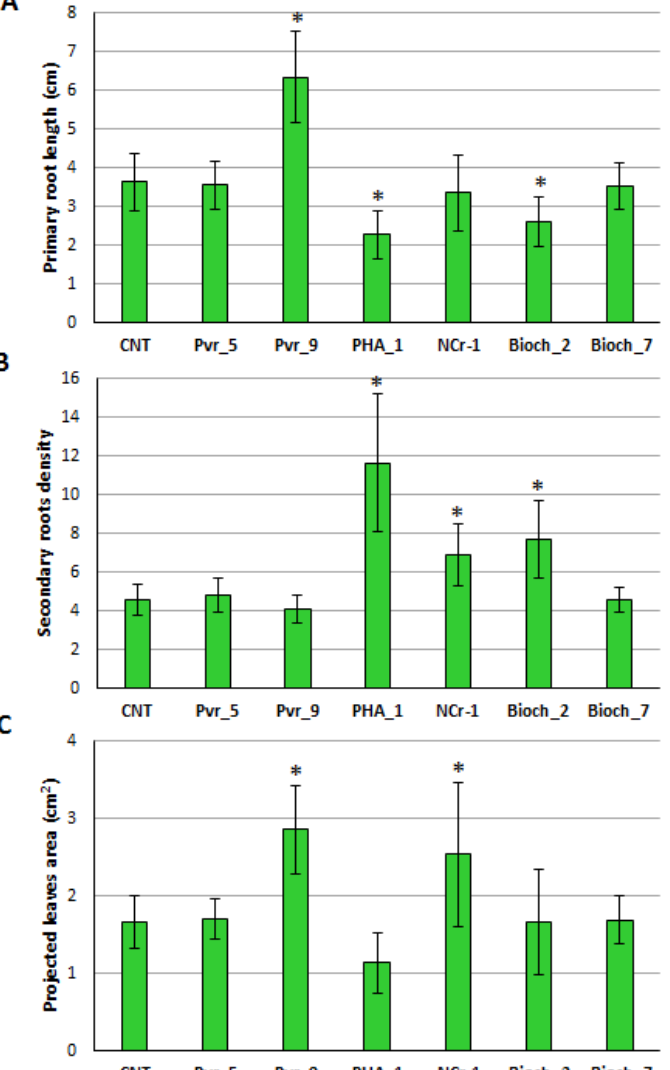
Figure 1. Effect of bacterial inoculation on Arabidopsis 14-day-old seedling morphological